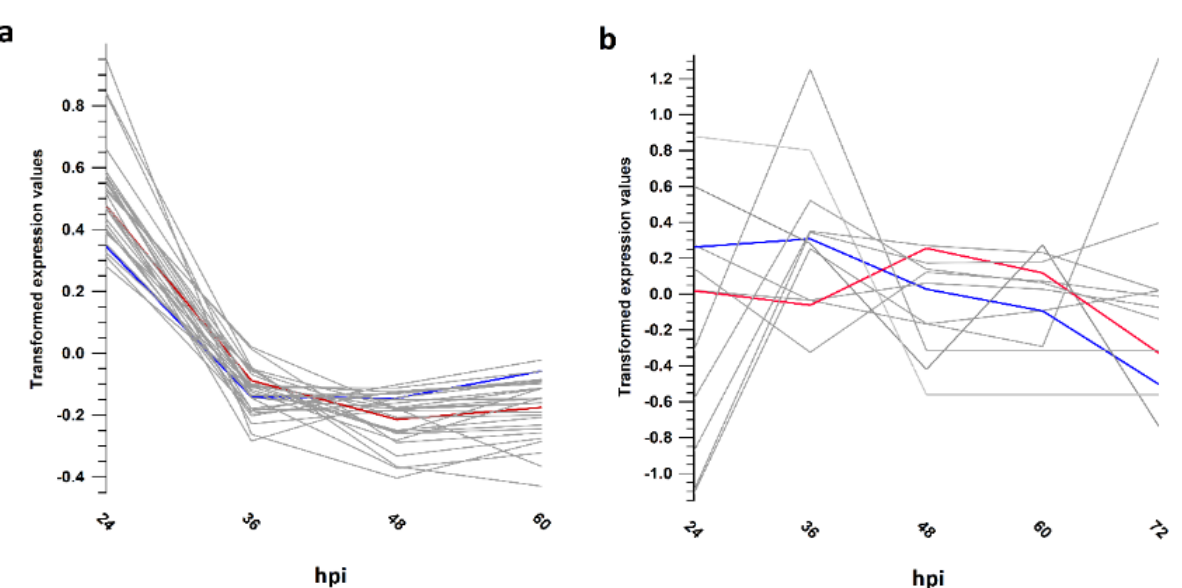
Figure 3. Expression trends analysis. The transcripts have been clustered in five groups based on their mean expression values per time point (Figure S3). ( a ) HaHV-1 cluster 3, including genes with decreasing expression trends along infection. ( b ) OsHV-1 cluster 3, including genes with decreasing expression trends along infection. The blue lines indicated the expression trend of the DNA polymerases, whereas the red lines indicated HaHV-1 75.1sc and OsHV-1 30.5sc .